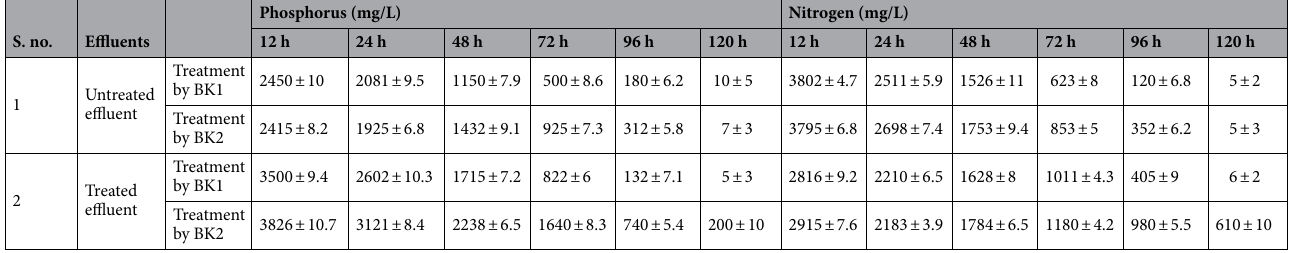
Table 6. Removal rate of nitrogen and phosphorus at different time